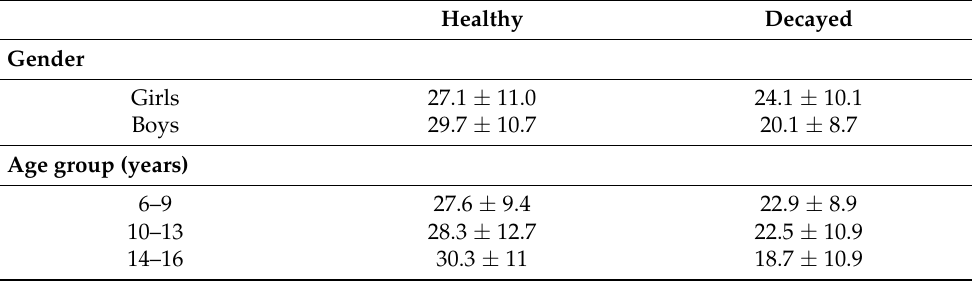
Table 2. Data on sCD14 salivary levels ( µ g/mL) reported according to gender and